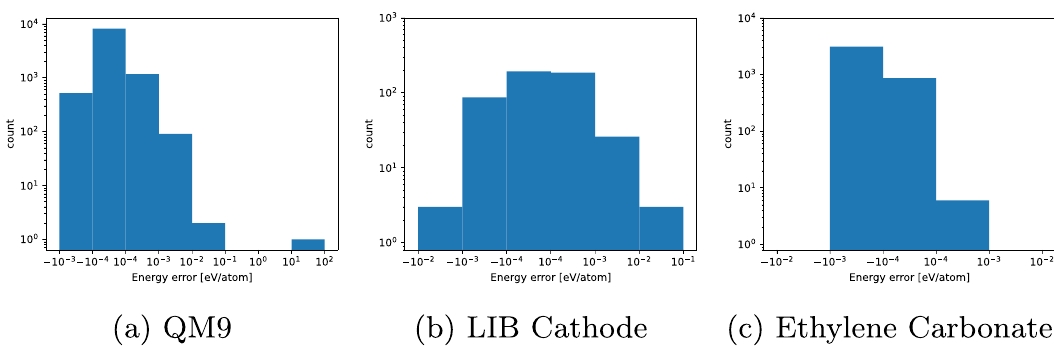
Fig. 4 Distribution of energy errors obtained from running non-self-consistent single point energy calculations with VASP using the predicted DeepDFT charge densities. The distribution of normalized (by number of atoms) energy errors are shown for three different datasets QM9 ( a ), LIB Cathode ( b ) and Ethylene Carbonate ( c ). The histograms use logarithmic bins and count scale to clearly show both the heavy concentration around 0 eV/atom and the long, narrow tail of errors.